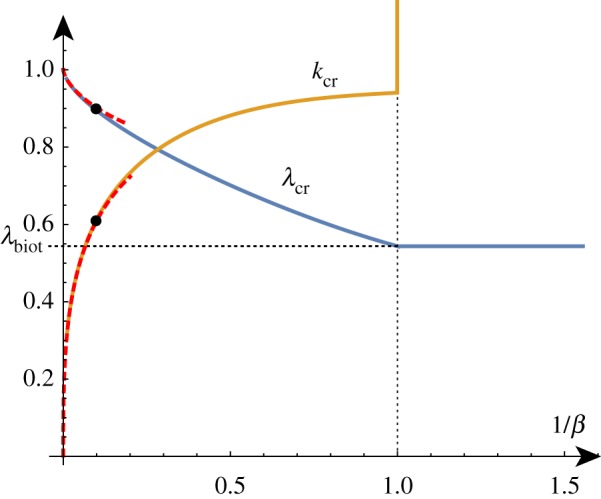
The critical wavenumber kcr and compression λcr as functions of β−1. The two points on the curves correspond to the critical values found for β = 10. For β < 1, the critical compression is given by the Biot value and kcr → ∞. The asymptotic estimates provide good approximations of these curves up to β ≈ 20 (red/dashed). Please note that the vertical axis in this figure and similar figures found later in the paper represents both the wavenumber and the compression as indicated by the curve labels. (Online version in colour.)